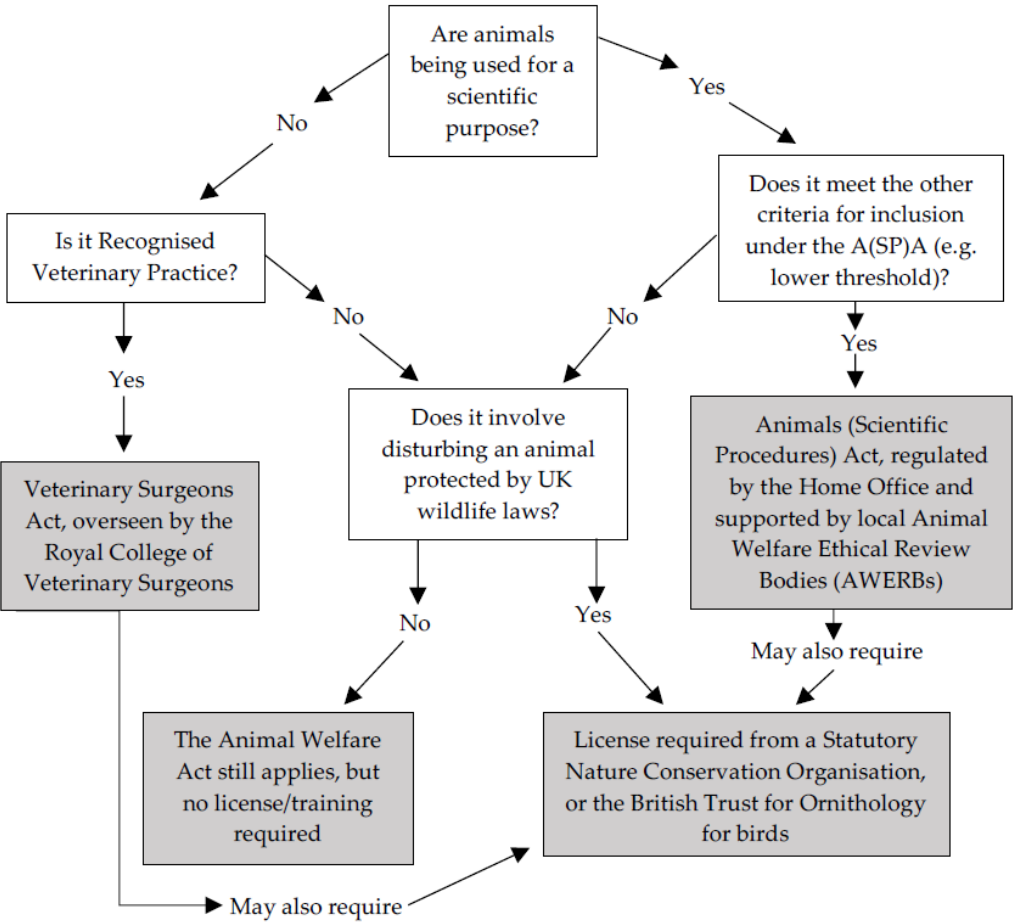
Figure 1. Decision tree, created by the authors, showing how to determine if work with animals in nonlaboratory settings falls under the A(SP)A or other UK laws. Information about laws is highlighted in grey boxes; arrows show conclusions or follow-on questions based on answers.